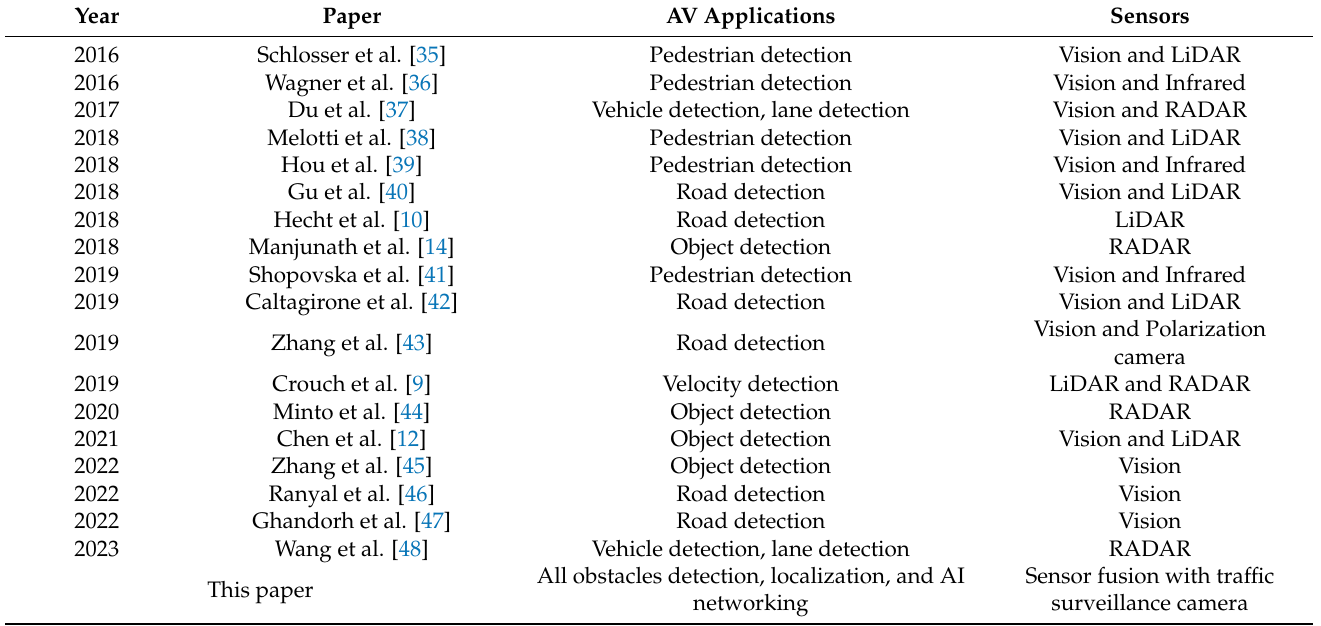
Table 2. A comparison with the recent related